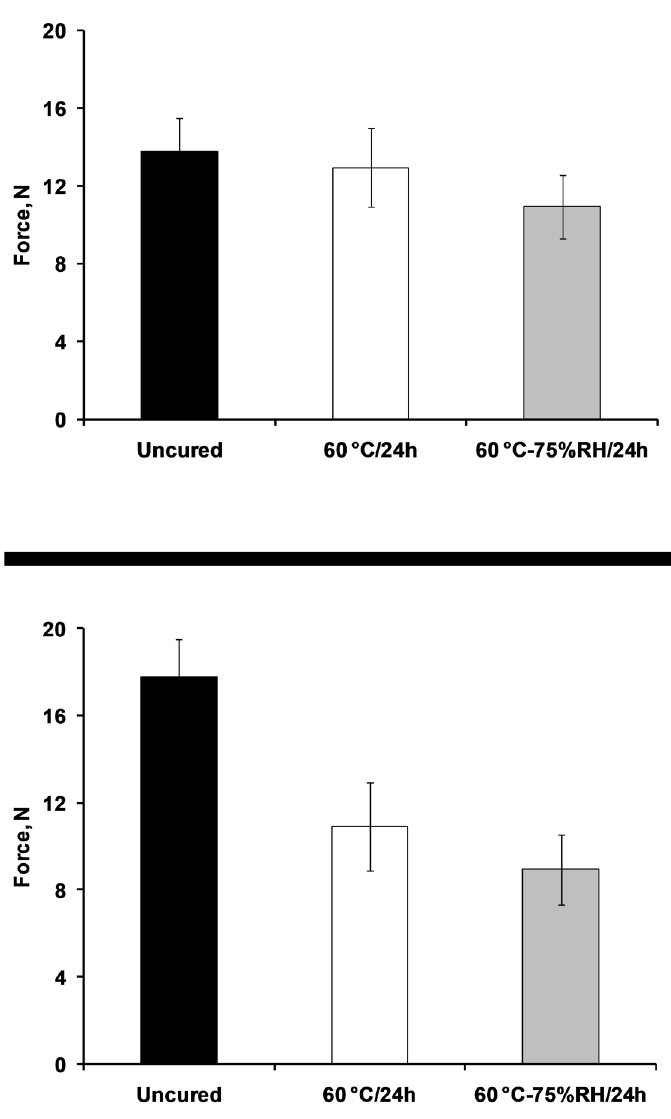
FIGURE 6 - Effect of curing on adhesive force of polymeric coatings to the drug-layered-cores using model tablets (drug layered and polymer coated like pellets): A) Aquacoat ® ECD and B) Eudragit ® NE 30D, coating level